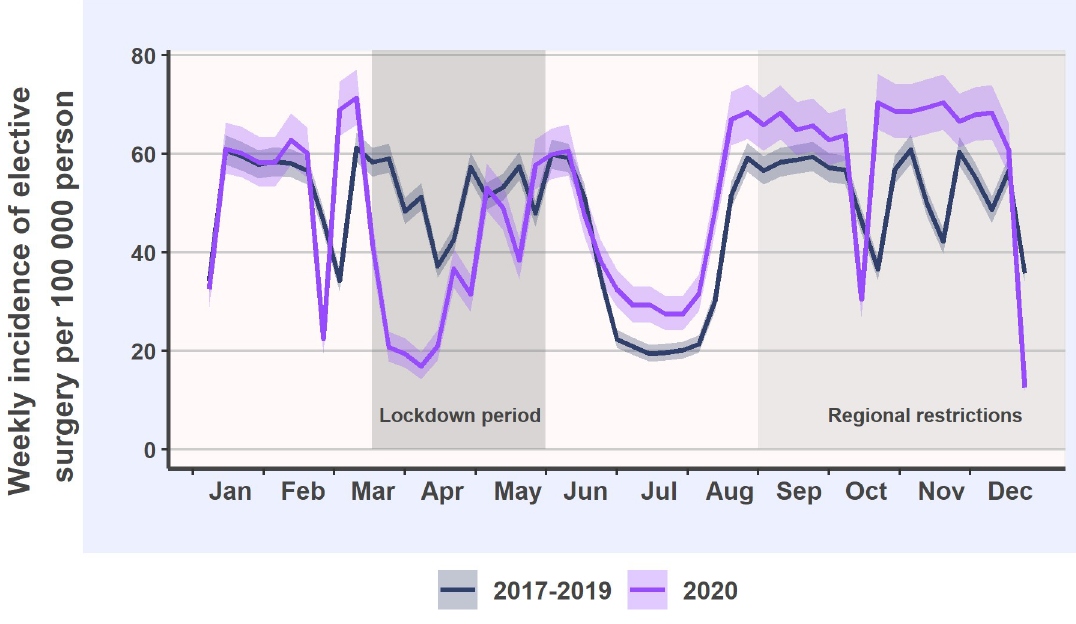
Fig 1. Weekly incidence and 95% confidence intervals of elective surgeries in 2020 and in the reference years.